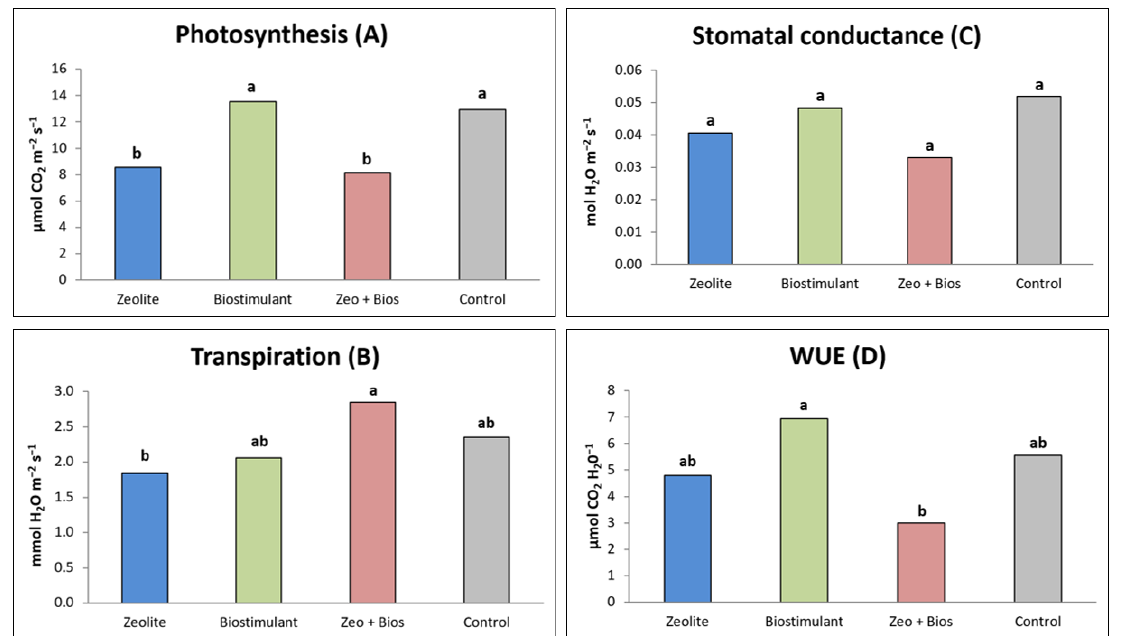
Figure 2. Photosynthetic rate ( A ), stomatal conductance ( B ), transpiration rate ( C ), and water use efficiency ( D ) measured at the end of the experiment in leaves of spinach plants treated with zeolite, A. nodosum -based biostimulant, and zeolite plus A. nodosum -based biostimulant (Zeo + Bios). Mean values ( n = 4) within a column followed by different lowercase and uppercase letters are significantly di ff erent at p < 0.05, respectively, according to the Least Signi fi cant Di ff erence test.